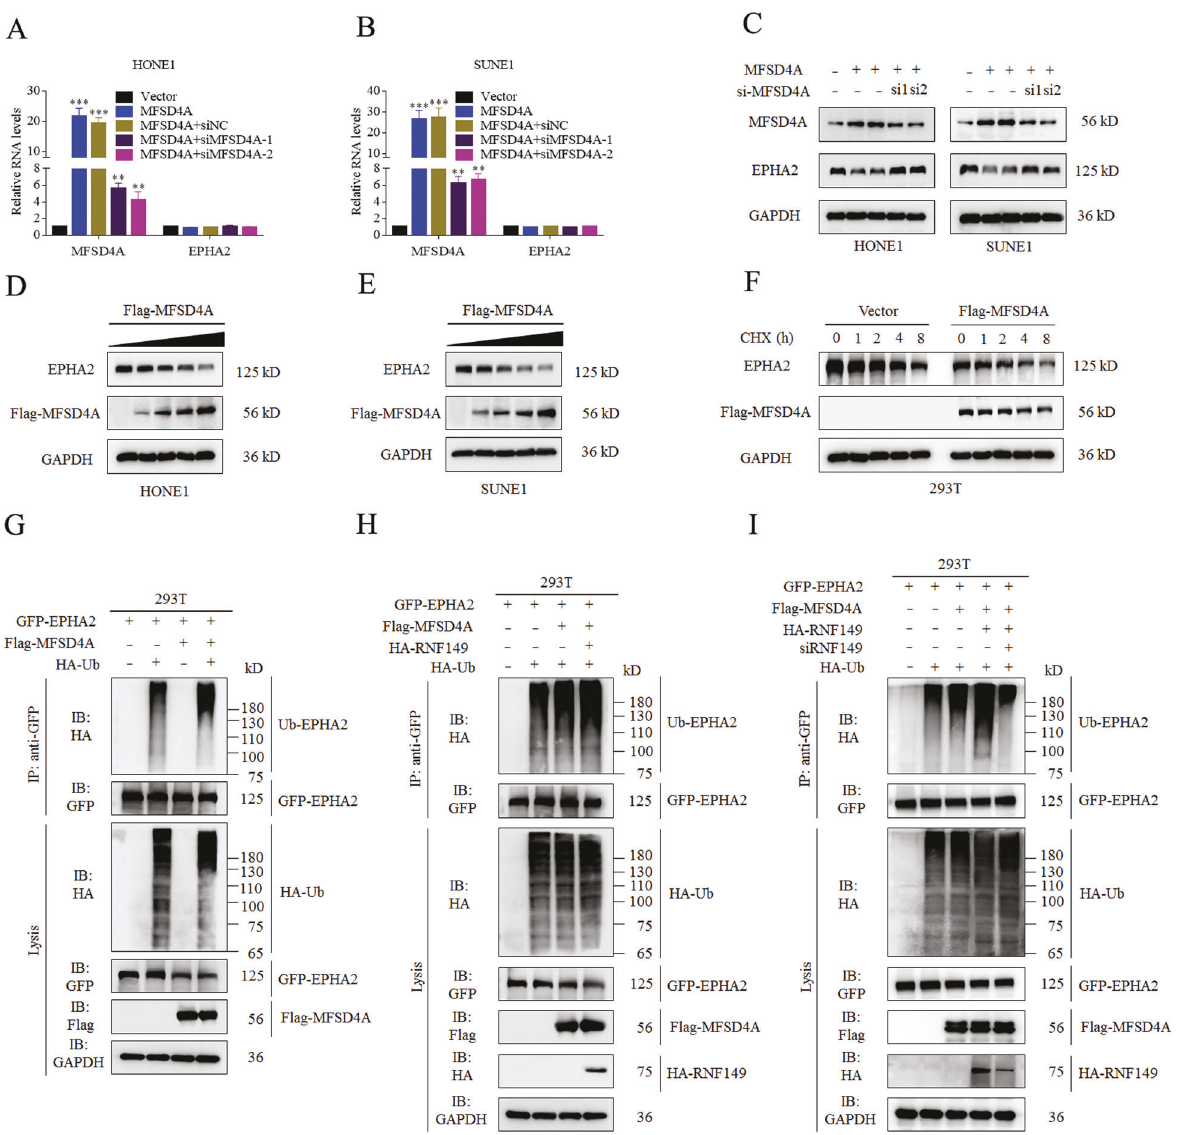
protein levels. Immunoblot analysis (with anti-Flag, EPHA2, and GAPDH antibodies) in HONE1 ( D ) and SUNE1 ( E ) cells transfected with various doses of Flag-MFSD4A (0, 0.25, 0.5, 1, and 2 μ g). F Immunoblot analysis of Flag-MFSD4A, EPHA2, and GAPDH in 293 T cells transfected with